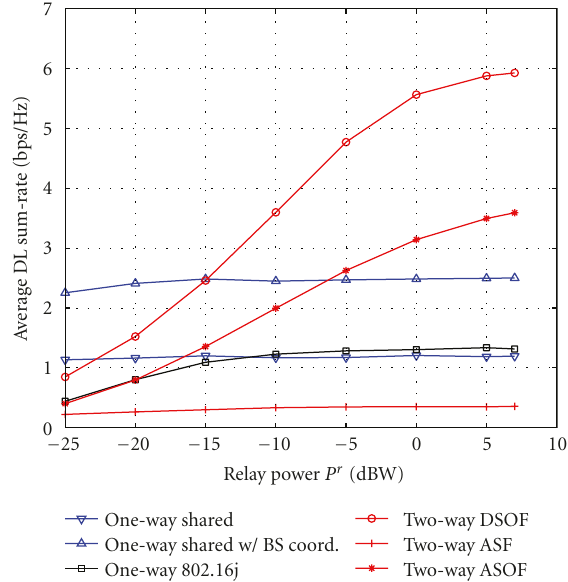
Figure 7: UL sum rate performance versus average relay transmit